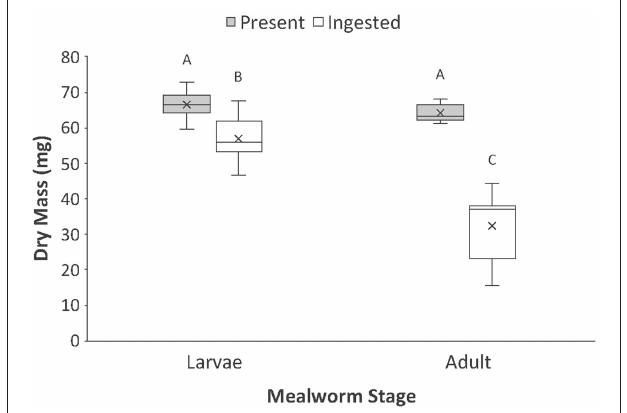
FIGURE 1 | Comparison of the total dry mass present vs. ingested by spiders when feeding on larval and adult mealworm beetles. Boxplots display the interquartile range (the box), median (line in the box), mean (x in the box), minimum (lower whisker), maximum (upper whisker), and any outliers (additional points). Treatments with different letters are significantly different from each other in post hoc